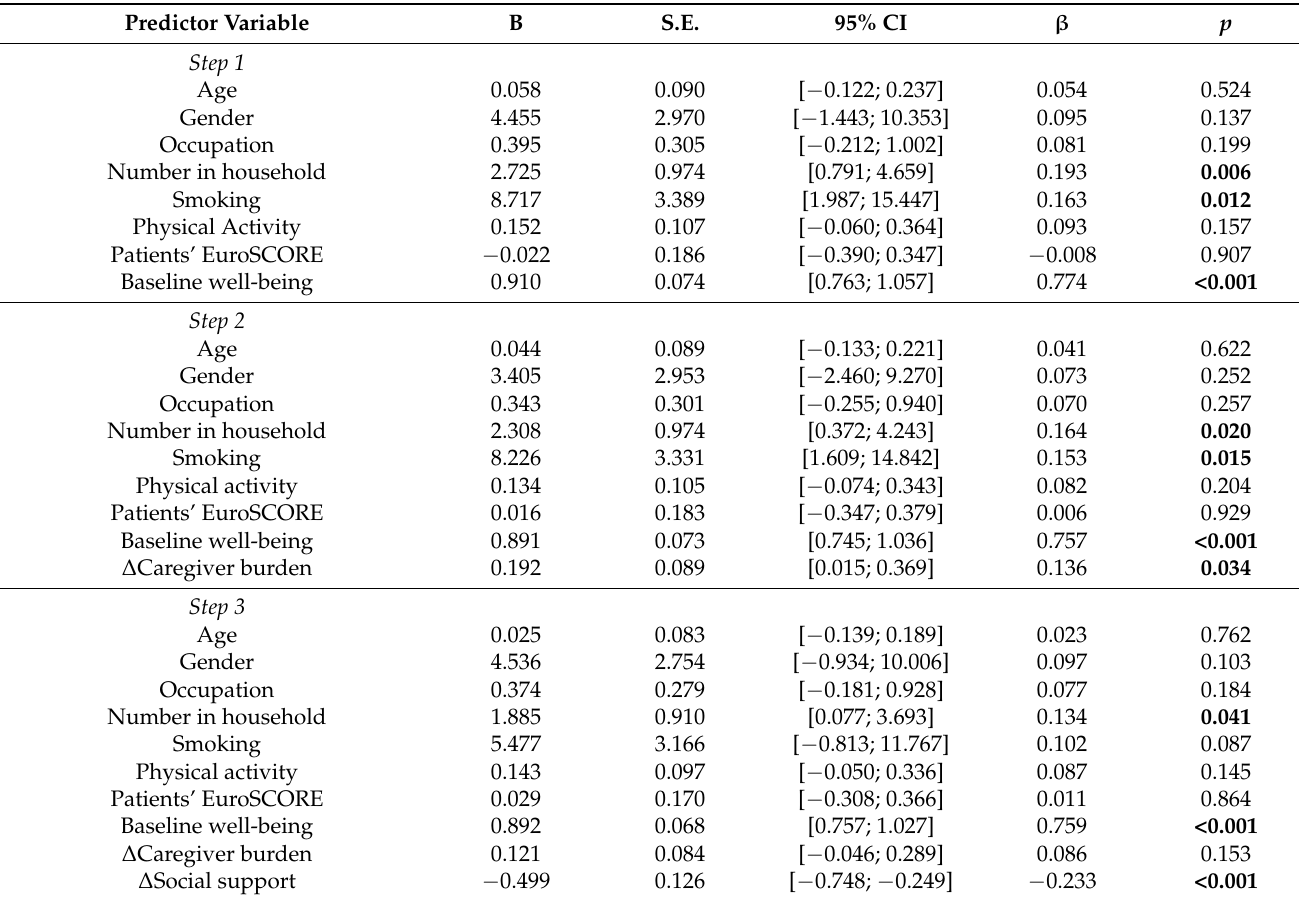
Table 5. Hierarchical linear regression of subjective well-being on caregiver burden and social support (N = 101). Predictor